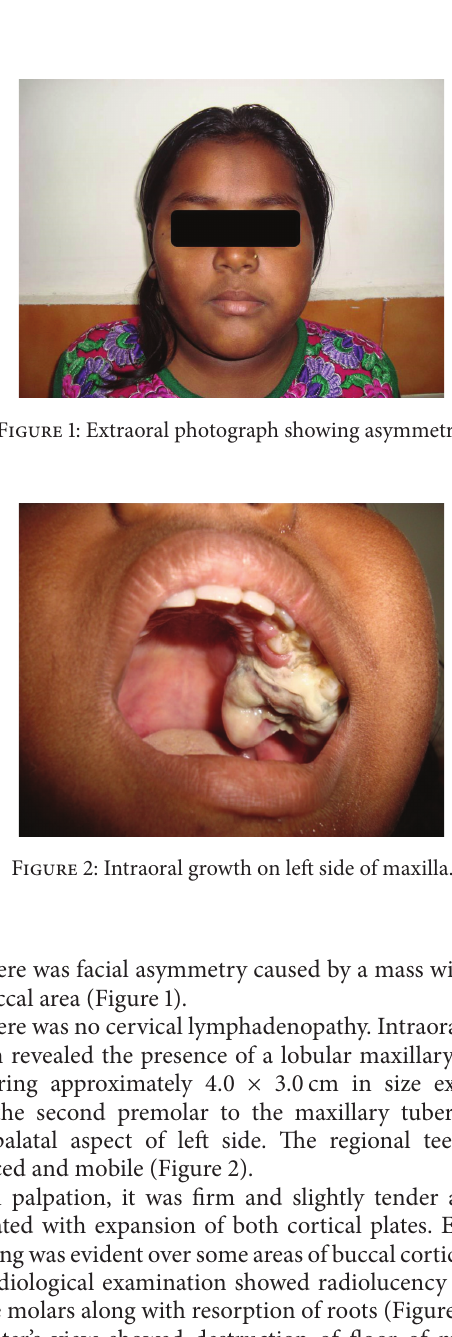
There was facial asymmetry caused by a mass within the left buccal area (Figure 1).